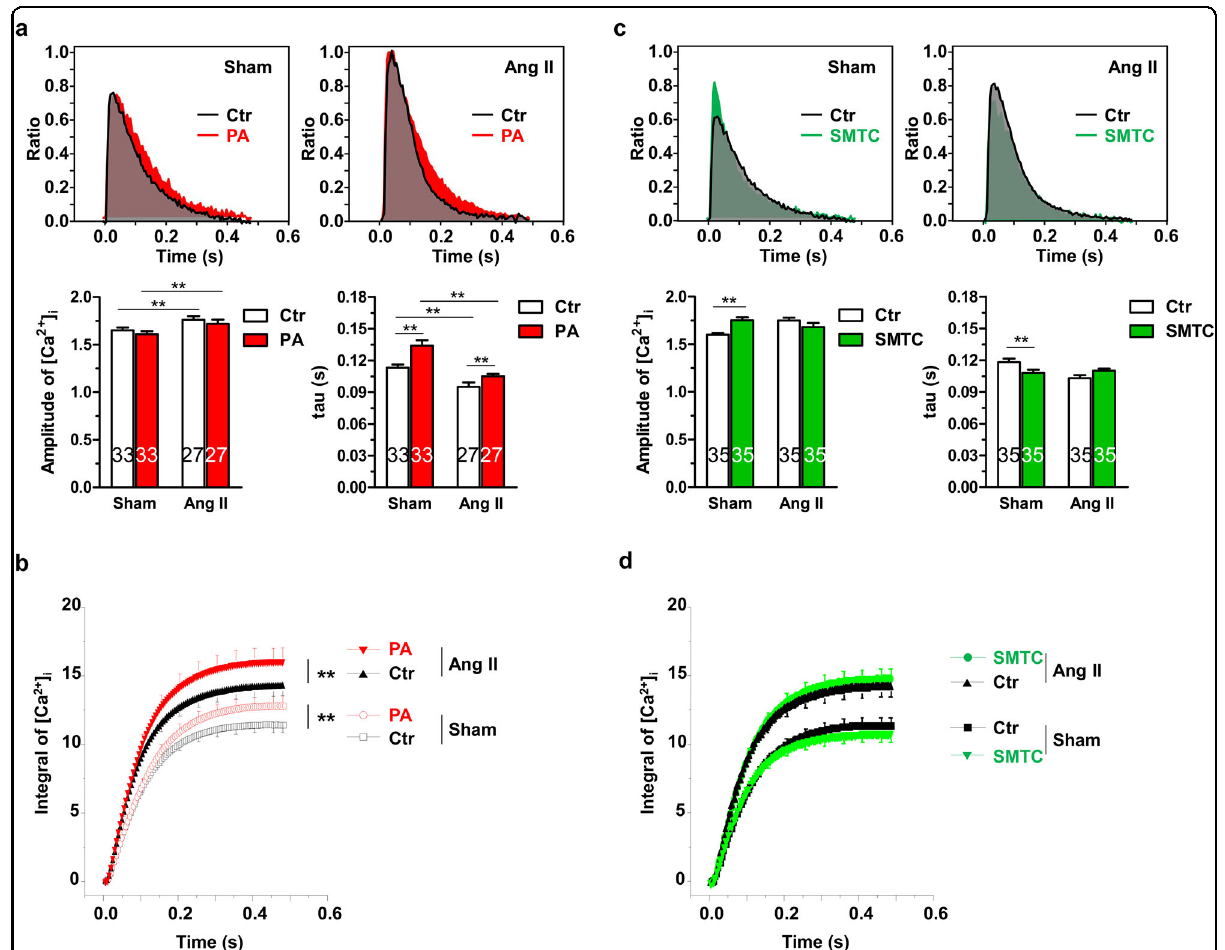
Fig. 6 Effects of palmitic acid and SMTC on intracellular Ca 2 + levels in LV myocytes from normal and Ang II-treated rats. a , b Representative traces of [Ca 2 + ] i , mean ± S.D. of the amplitude, and the tau of [Ca 2 + ] i after treatment with PA ( a , 100 μ M) or SMTC ( b , 100 nM) in LV myocytes from sham and Ang II-treated rats. c , d Integral of [Ca 2 + ] i during one stimulation protocol after treatment with PA ( c ) or SMTC ( d ) in LV myocytes from sham and Ang II-treated rats. ** P <